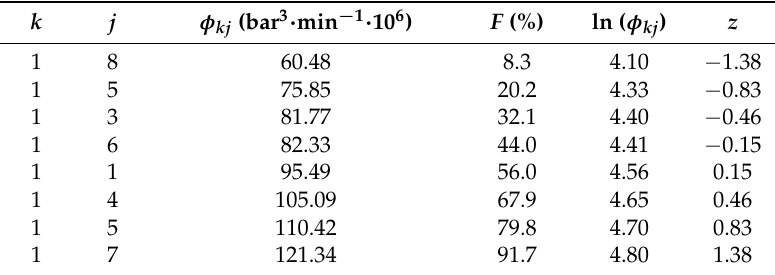
Table 1. Damage factors for the task k = 1 (loading task).